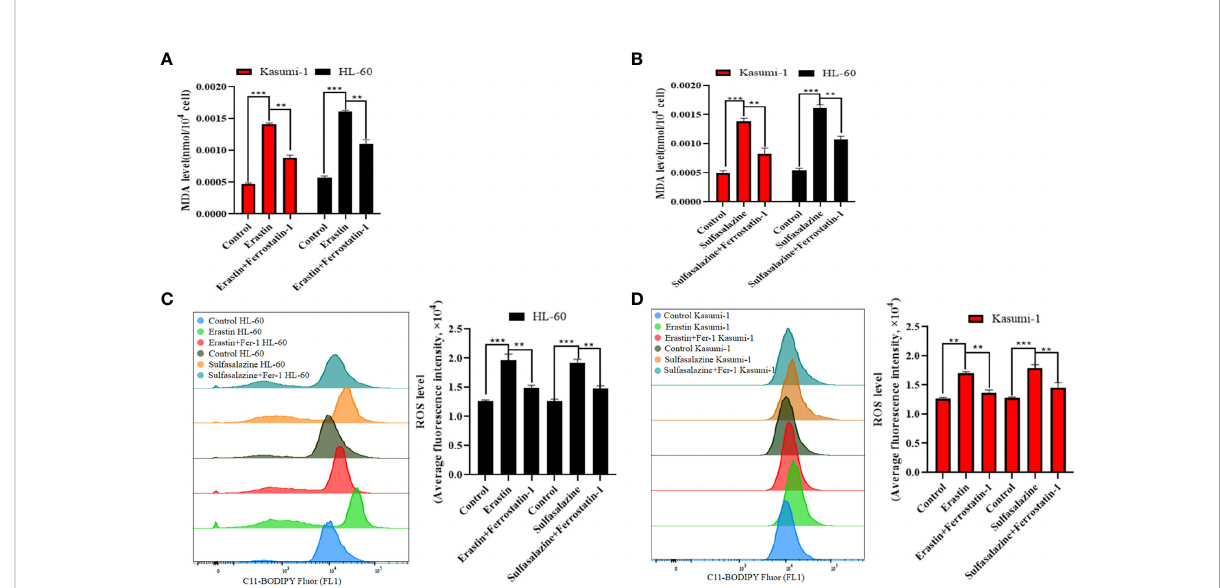
FIGURE 7 Detection of lipid peroxidation levels in Kasumi-1 and HL-60 cells after 24 h treatment with 5 µM erastin or 300 µM sulfasalazine. (A) MDA levels were tested in Kasumi-1 and HL-60 cells cultured for 24 h under normal, 5 µM erastin or 5 µM erastin+2 µM Ferrostatin-1 treatment conditions. (B) MDA levels were tested in Kasumi-1 and HL-60 cells cultured for 24 h under normal, 300 µM sulfasalazine or 300 µM sulfasalazine+2 µM Ferrostatin-1 treatment conditions. (C) Flow cytometry was used to detect ROS levels in HL-60 cell cultured for 24 h after normal, 5 µM erastin or 5 µM erastin+2 µM Ferrostatin-1 and normal, 300 µM sulfasalazine or 300 µM sulfasalazine+2 µM Ferrostatin-1 treatment conditions. (D) Flow cytometry was used to detect ROS levels in Kasumi-1 cell cultured for 24 h after normal, 5 µM erastin or 5 µM erastin+2 µM Ferrostatin-1 and normal, 300 µM sulfasalazine or 300 µM sulfasalazine+2 µM Ferrostatin-1 treatment conditions. ** P < 0.01; *** P <